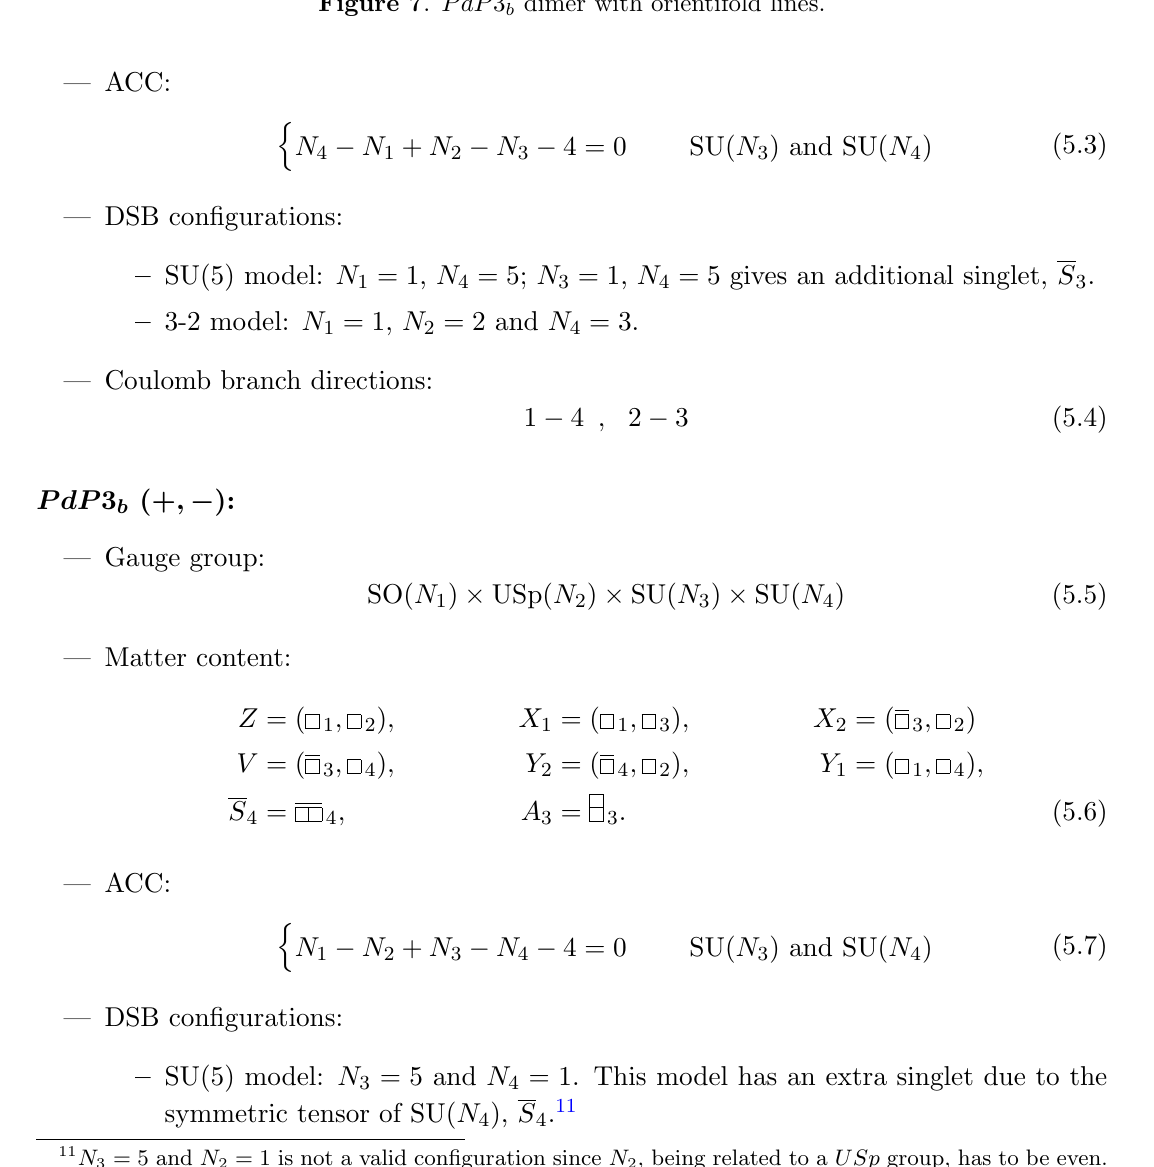
Figure 7 . PdP 3 b dimer with orientifold